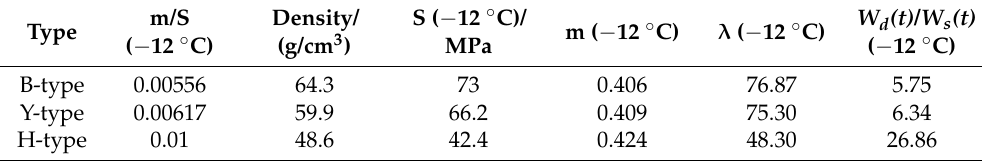
Table 5. Different evaluation indexes for low-temperature properties. Table 5. Di ff erent evaluation indexes for low-temperature properties.